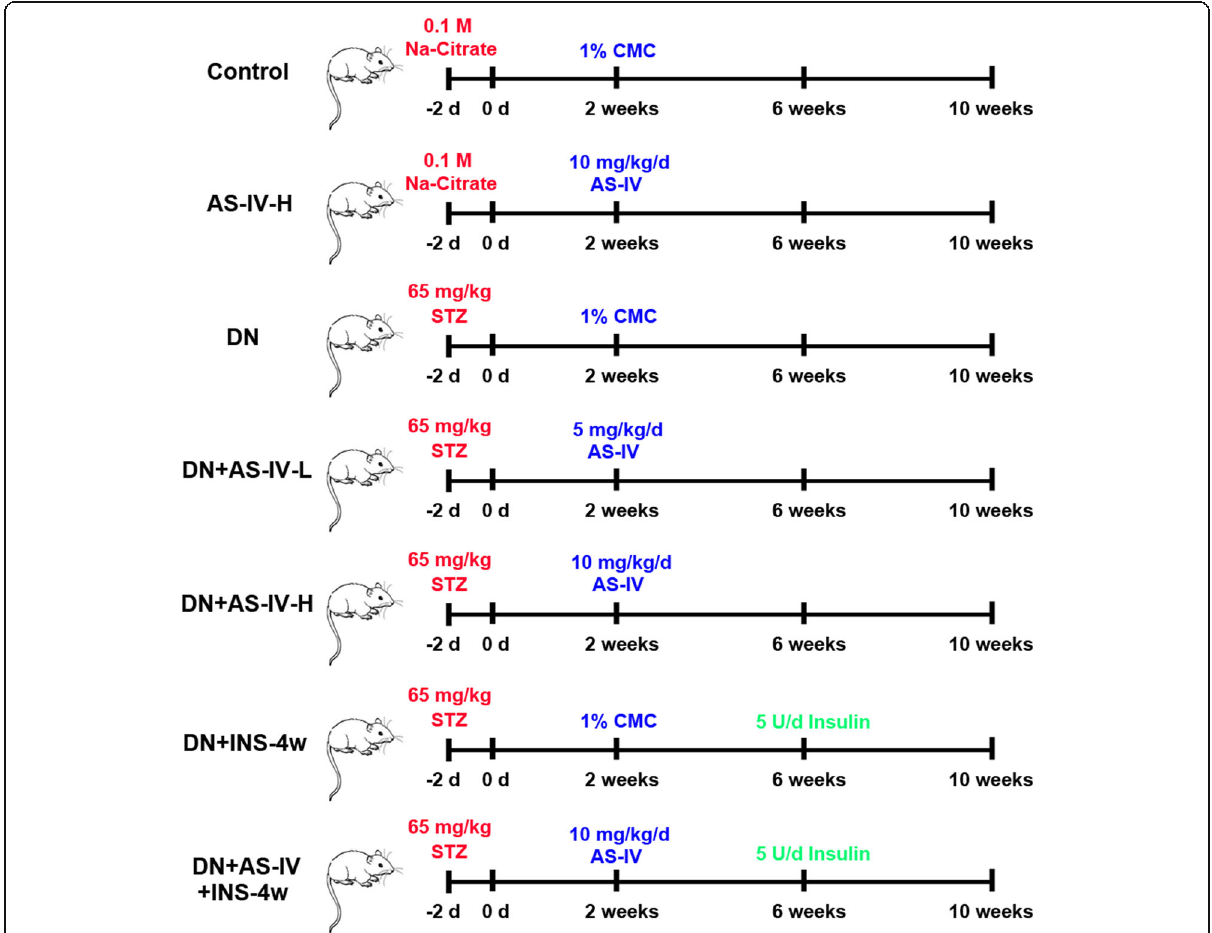
Fig. 1 Experimental groups and treatment schedules. AS-IV: Astragaloside IV; STZ: streptozotocin; CMC: carboxymethyl cellulose; Na-Citrate: sodium